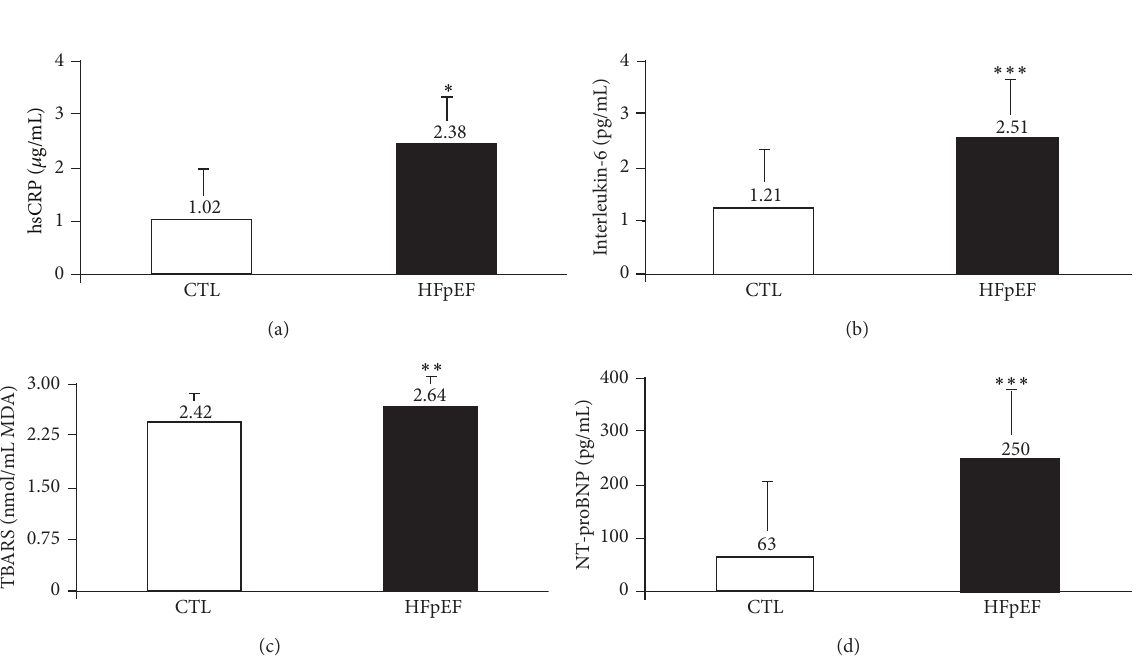
Figure 1: Circulating biomarker levels for patients with HFpEF versus healthy control subjects. NT-proBNP: N-terminal prohormone of brain natriuretic peptide; hsCRP: high-sensitivity C-reactive protein; TBARS: thiobarbituric acid reactive substances. Values are expressed as adjusted geometric mean or adjusted mean ± error. Significantly different from HFpEF values: ∗ 𝑃 < 0.05 ; ∗∗ 𝑃 < 0.01 ; ∗∗∗ 𝑃 < 0.001